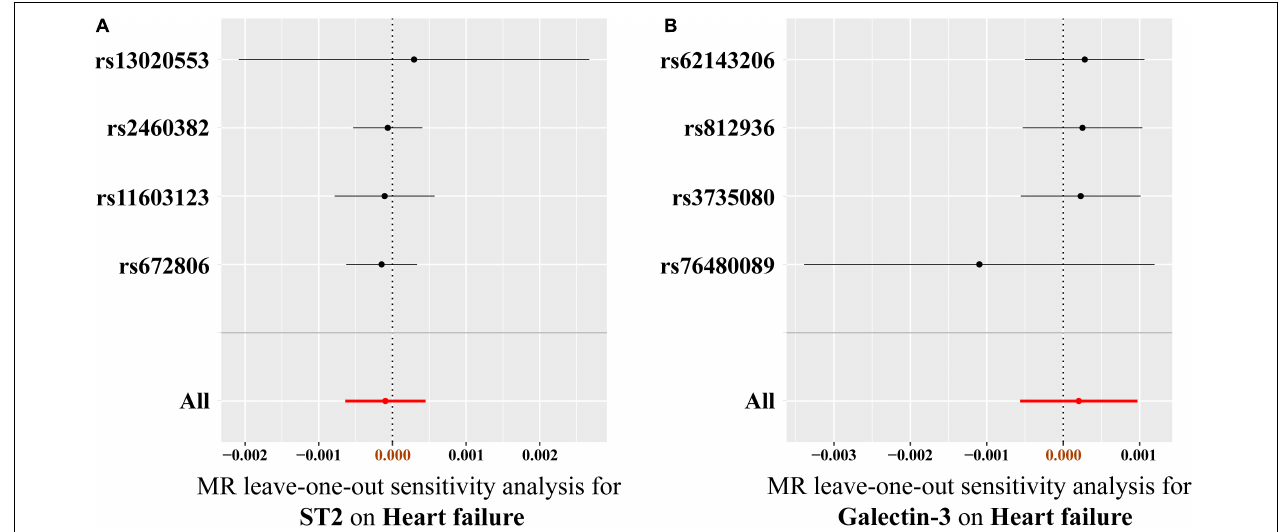
FIGURE 5 | Leave-one-out analysis of the causal association between circulating ST2 and galectin-3 levels and heart failure risk. (A) ST2, (B) galectin-3. Each SNP was excluded sequentially and the MR estimate effect was recalculated. Visually, the leave-one-out analysis plot illustrated that the results were not driven by any SNPs. SNP, single-nucleotide polymorphism; MR, Mendelian